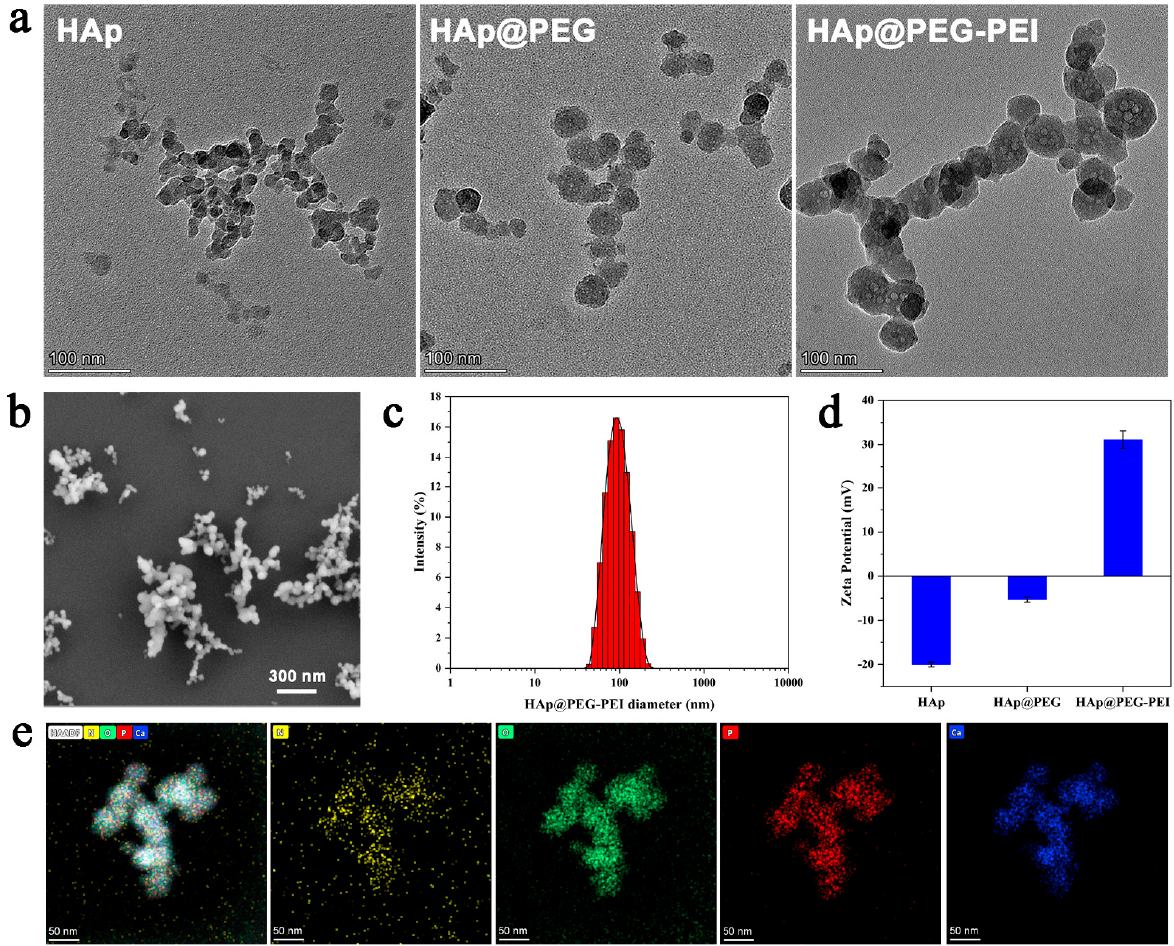
Figure 1. ( a ) TEM images of HAp, HAp@PEG and HAp@PEG-PEI, ( b ) SEM image, ( c ) hydrodynamic size distributions, ( d ) zeta potential, and ( e ) TEM elemental color mapping of HAp@PEG-PEI. Elements: N (yellow), O (green), P (red) and Ca (blue).